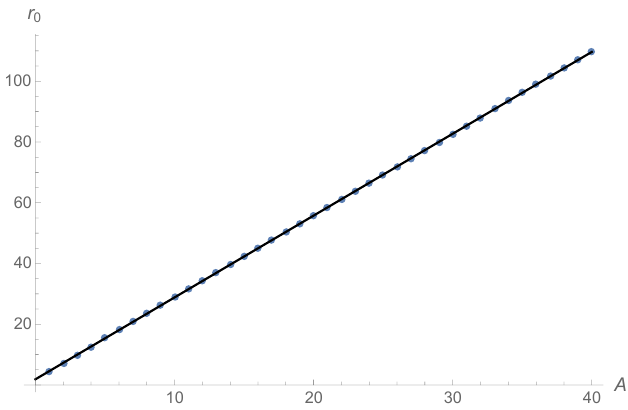
Figure 15 . Value of r 0 as a function of A up to 40 and its linear